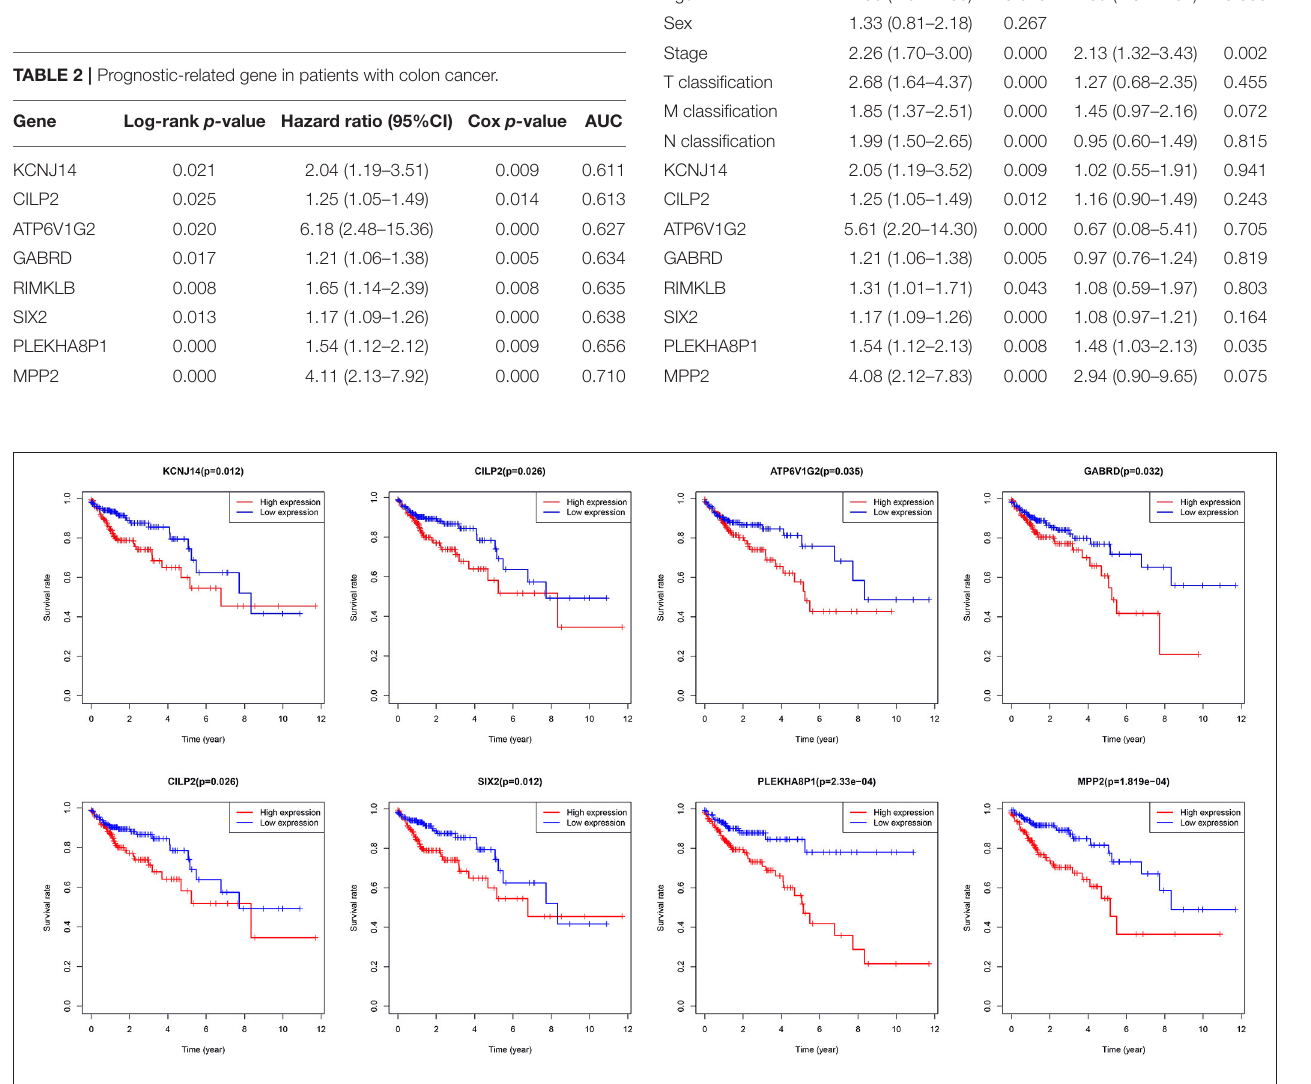
FIGURE 1 | Survival curves of eight genes, KCNJ14, CILP2, ATP6V1G2, GABRD, RIMKLB, SIX2, PLEKHA8P1, and MPP2.